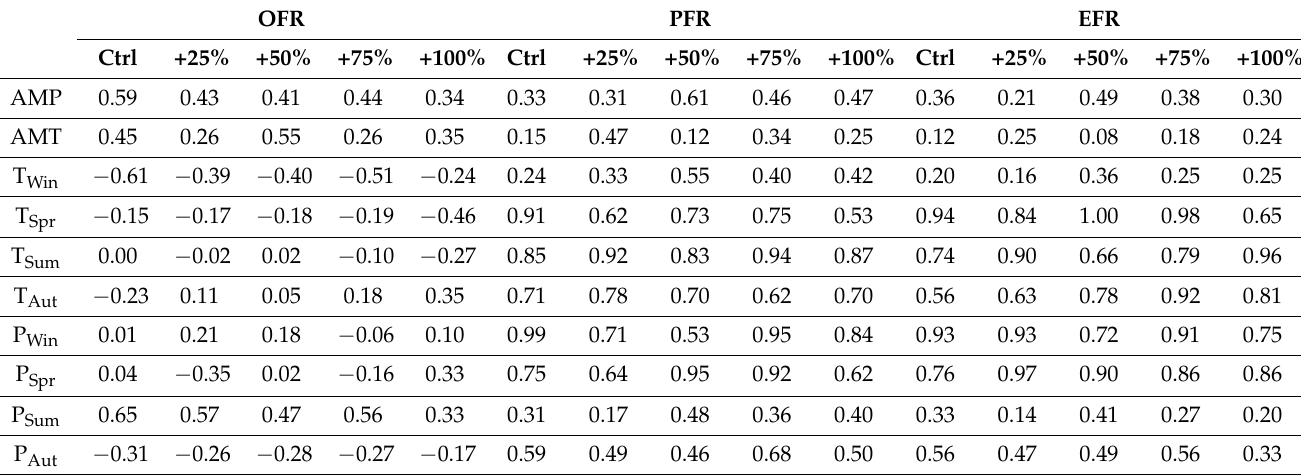
Table 3. Correlations between climate factors and fruit ripening